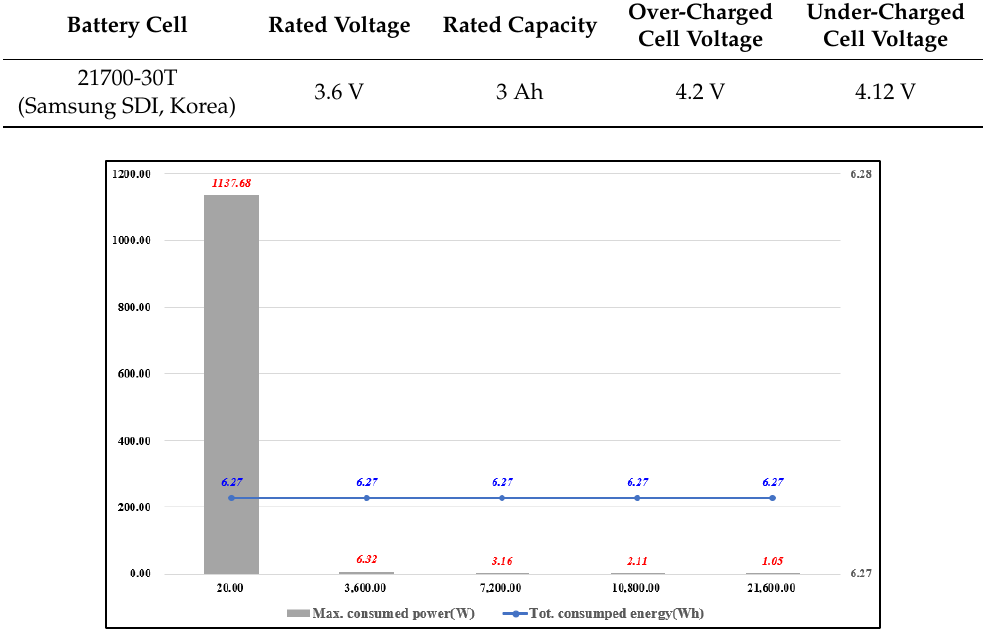
Figure 7. Power and energy loss comparisons with balancing time in the PCB method.